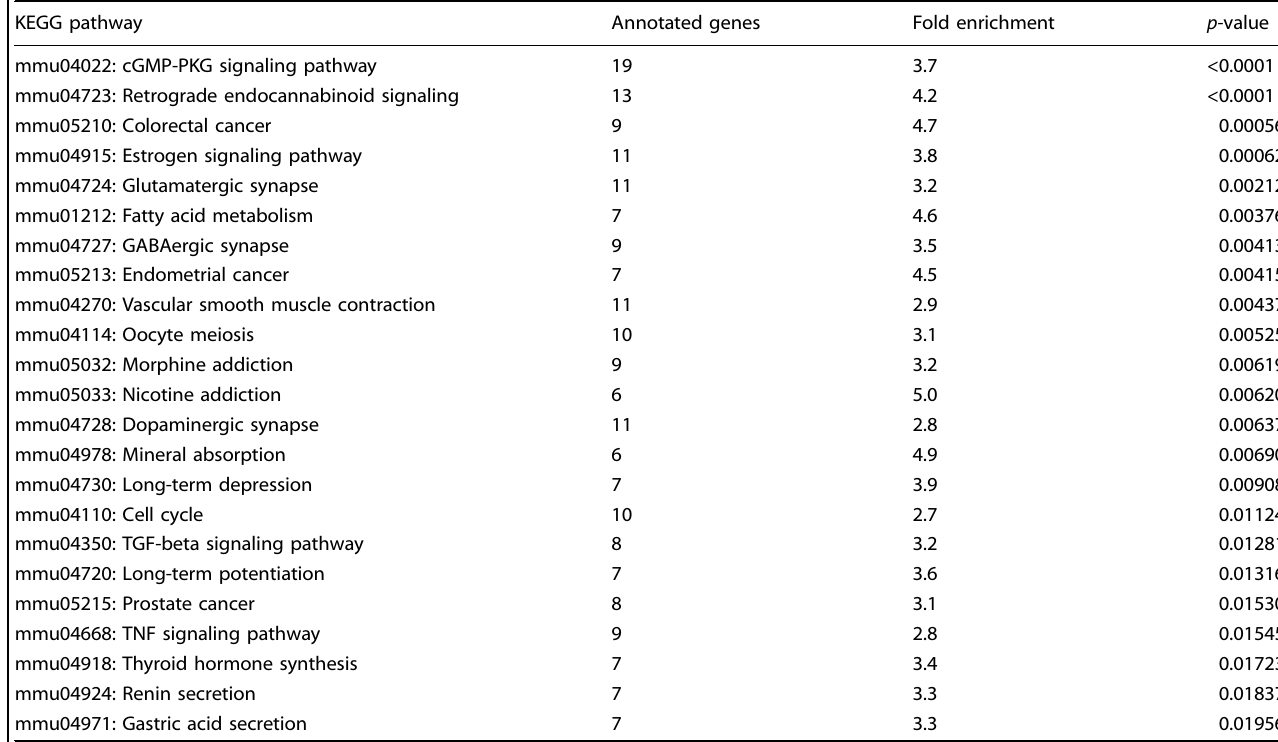
Table 2. KEGG pathways enriched in the rosmarinic acid group. KEGG pathway Annotated